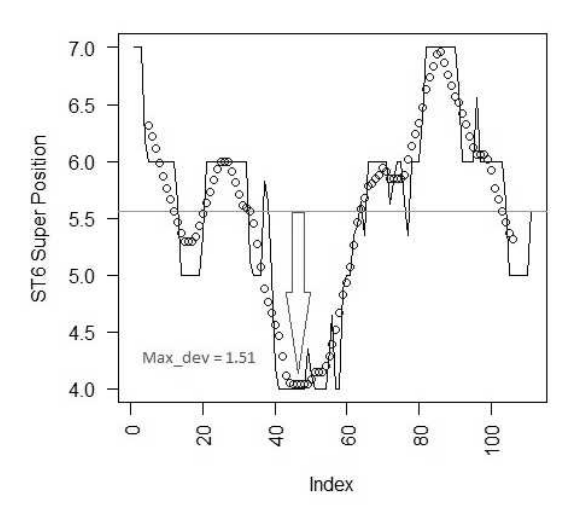
Figure 2: The ST6 super position values (solid) and an average fil- tered curve (n=10) (dotted). The straight line indicates the mean of the ST6 super position. Max_dev (arrow) is the calculated maximum difference of the mean of the ST6 super position and the filtered curve.